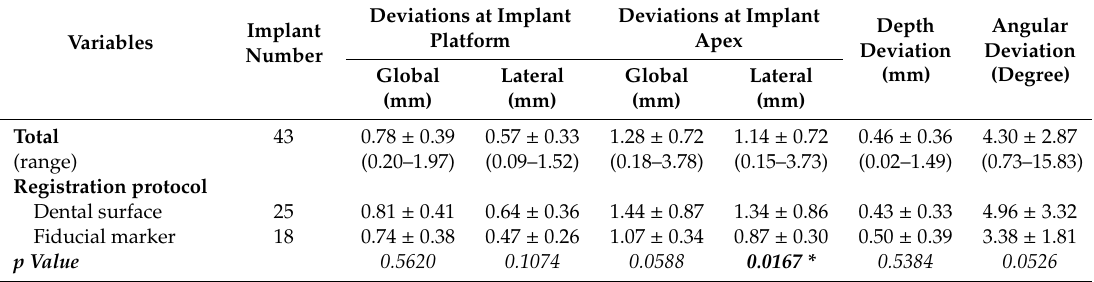
Table 1. Deviations between planned and placed implant position by registration